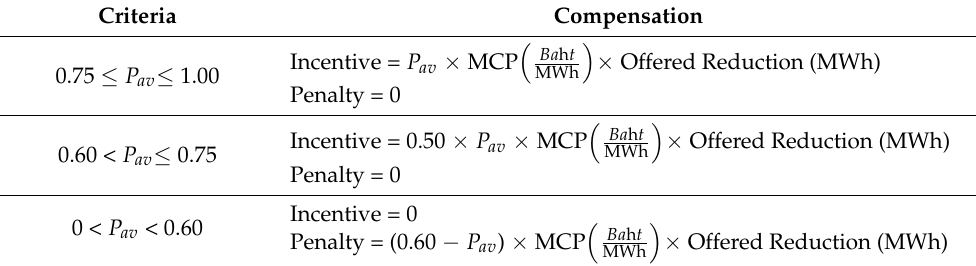
Table 3. Evaluation criteria and compensation adapted from